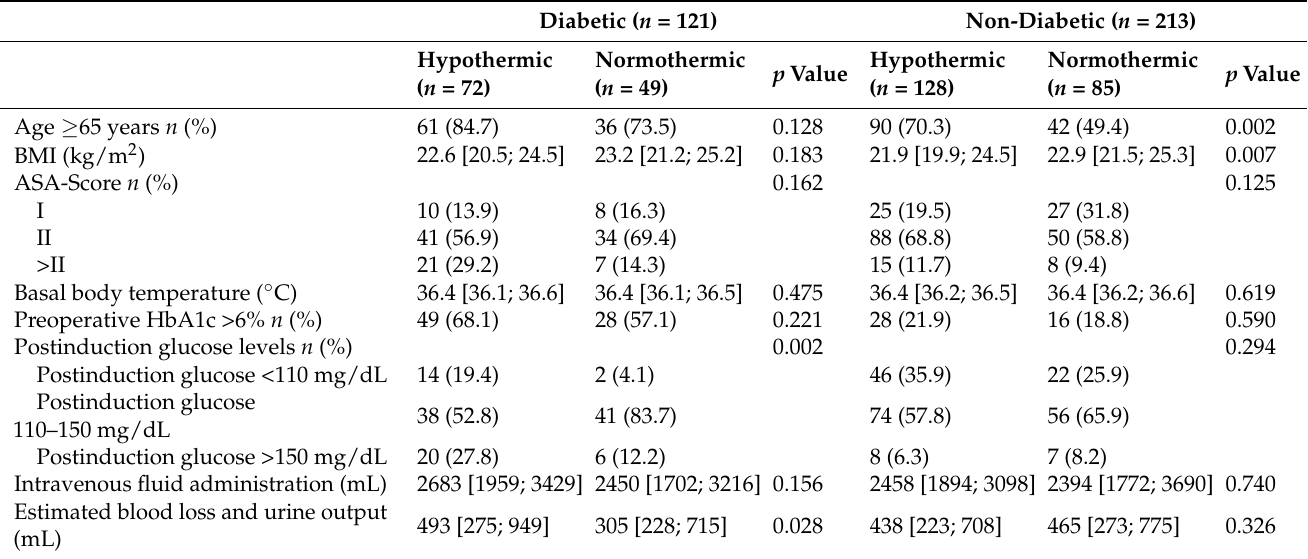
Table 4. Patient characteristics in patients with and without